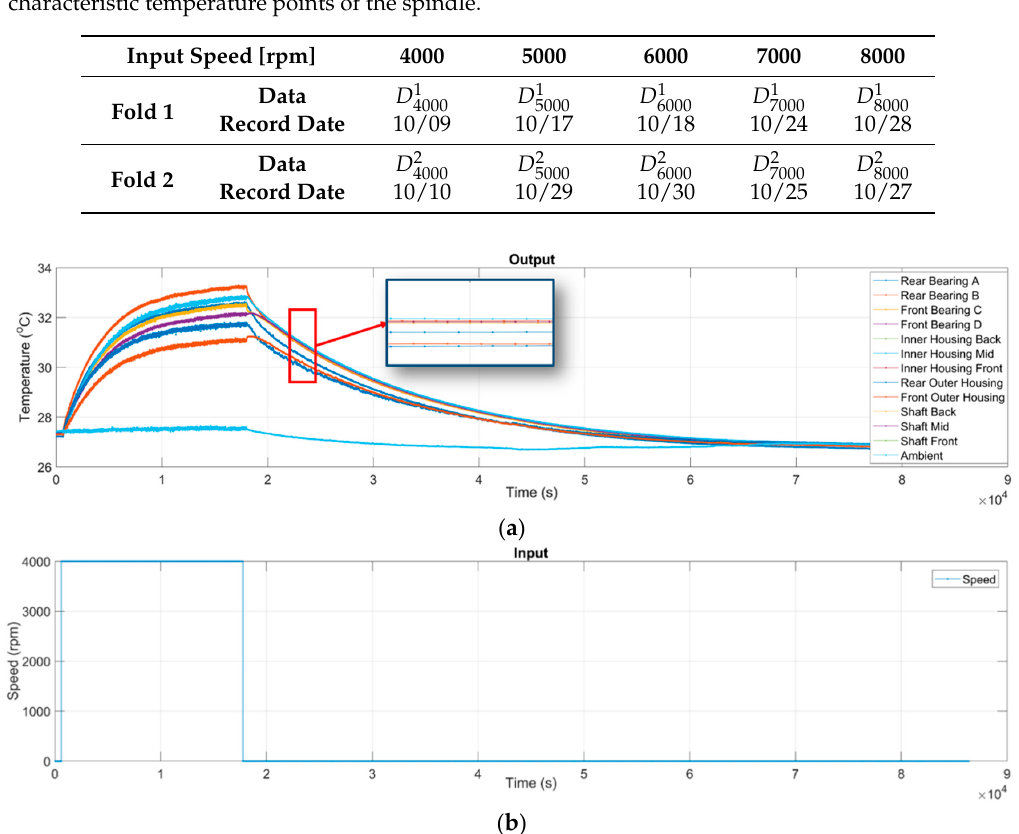
Table 4. The data descriptions for thermal-feature model identification, all data were recorded in the year 2018. The superscript of the data name indicates the fold number and the subscript indicates the input spindle speed. The format of the recorded date is month/day. Note that each data contain 1 time-series of input spindle speed and 7 time-series of temperature variation corresponding to 7 characteristic temperature points of the spindle.